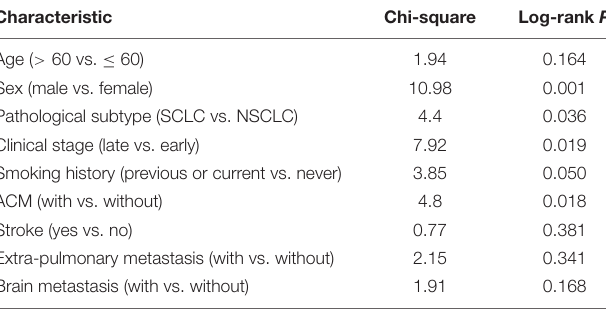
TABLE 4 | Univariate analyses of overall survival.